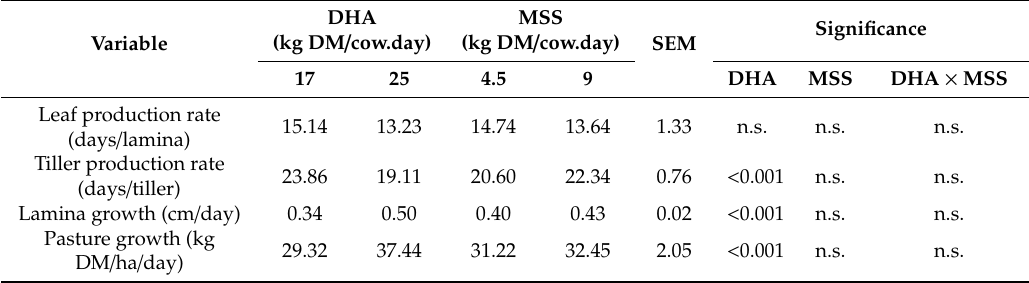
Table 5. E ff ect of daily herbage allowance (DHA) and maize silage supplementation (MSS) level on pasture regrowth rates.